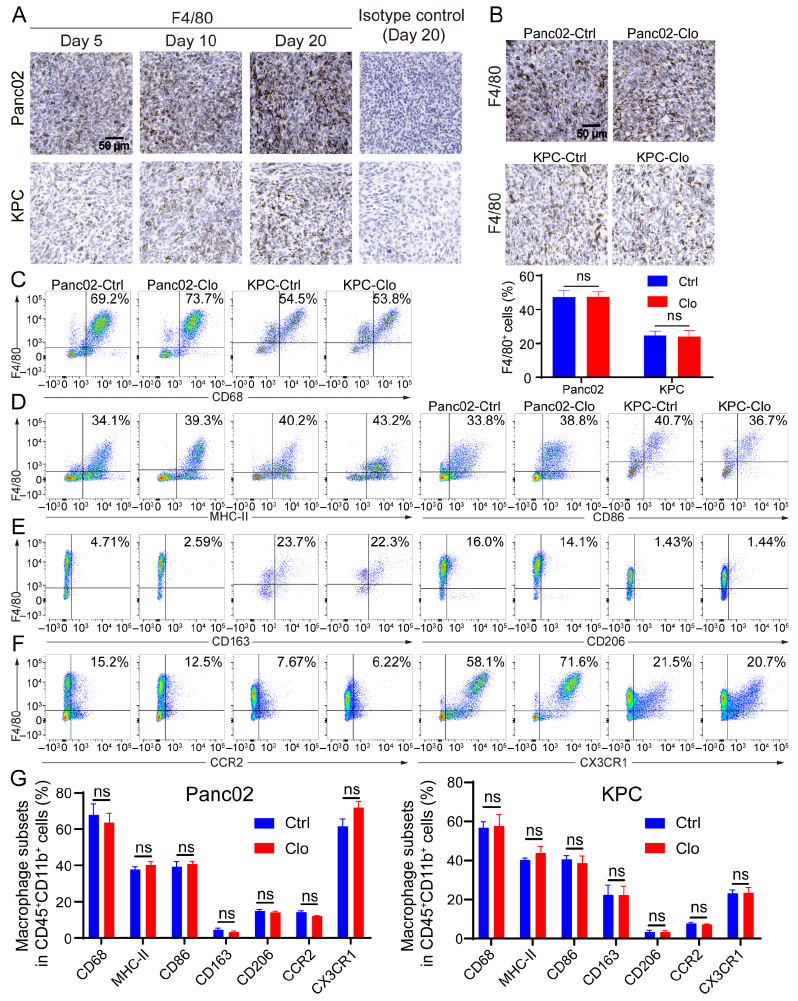
Figure 3. Macrophage populations express a mixture of subset markers with or without macrophage targeting. ( A ) F4/80 (a marker of macrophages) increased as tumor lesions progressed to palpable tumors. Representative IHC images on the 5th, 10th, and 20th days after tumor inoculation and the isotype control (using the slide from day 20) are shown. ( B ) Representative images of pancreatic tissue from the Panc02 and KPC mouse models show a high level of F4/80 + macrophage infiltration with or without clodronate liposomes treatment. ( C – F ) Cells were isolated from tumors in mice treated with or without clodronate liposomes and analyzed by flow cytometry. For all dot plots, live cells were selected by gating based on zombie staining after gating on CD45 + cells, which excluded epithelial cells. CD11b + subpopulations were selected and further analyzed: ( C ) the macrophage markers CD68 and F4/80; ( D ) the M1-like markers MHC-II and CD86; ( E ) the M2-like markers CD163 and CD206; ( F ) the additional markers CCR2 and CX3CR1. ( G ) Statistical diagrams of macrophage subpopulations on live CD45 + CD11b + myeloid cells are shown. Data are shown as the mean ± SEM. Statistical analyses were carried out by Student’s t test. ns: not significant ( p >